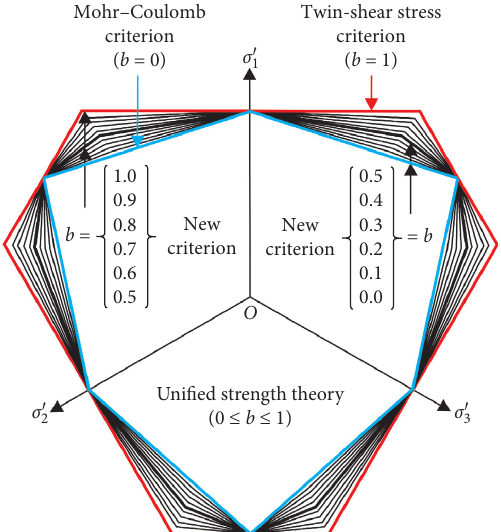
Figure 1: Limit loci of the unified strength theory on a deviatoric plane